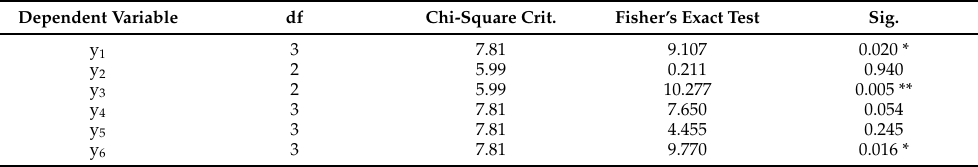
Table A2. Fisher’s exact test values depending on the supply chain rank, data for